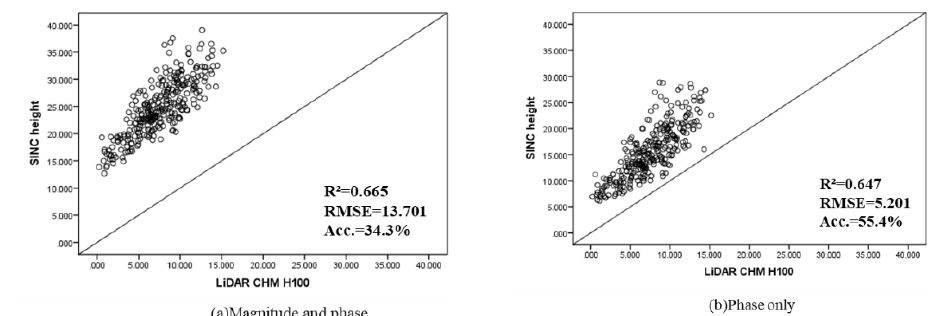
Figure 4. Estimation of forest height with two different coherence calculation algorithms